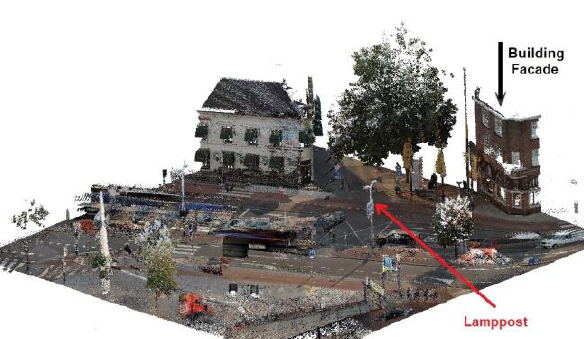
Figure 5. MLS point cloud of an urban scene enriched with RGB (source: Cyclomedia, the